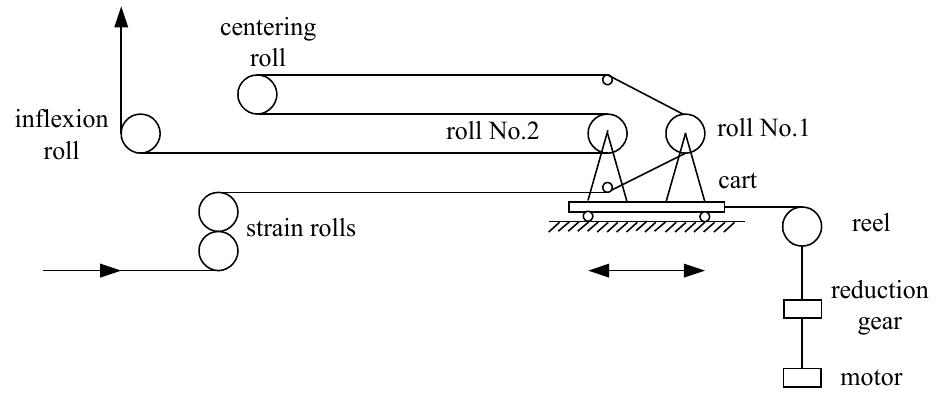
Figure 1. Kinematic diagram of a horizontal loop